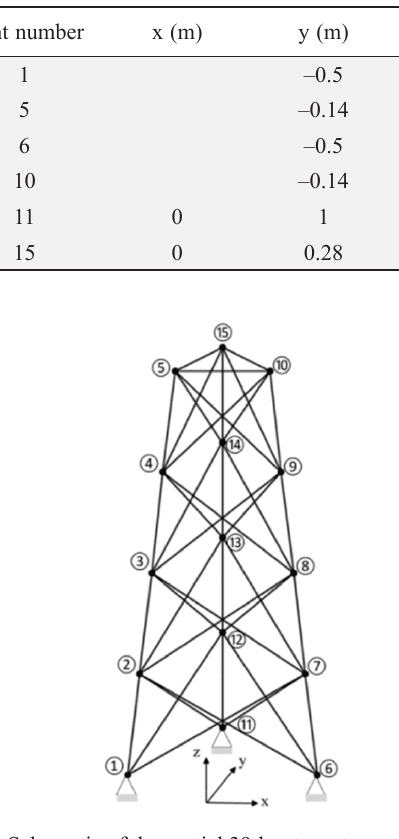
Fig. 12. Optimal layout for the spatial 39-bar truss problemFig. 11. Schematic of the spatial 39-bar truss